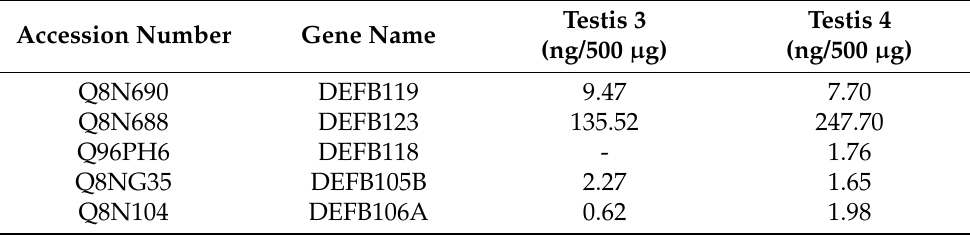
Table 1. The quantitative results of five beta-defensin proteins in the testis